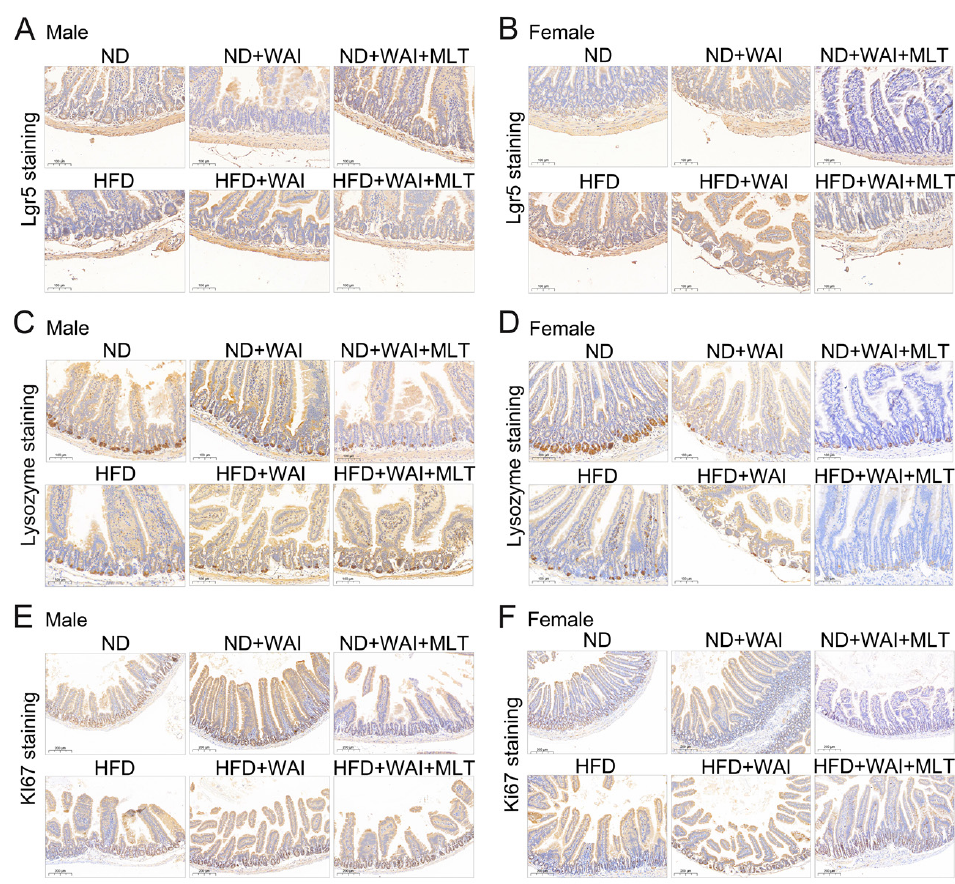
Figure 3. MLT enhances the regenerative ability of Lgr5 + ISCs after WAI. Representative immuno- histochemistry images showing the expression of Lgr5 + ( A ), lysozyme + ( C ), and Ki67 + ( E ) in small intestinal sections from male mice. Representative immunohistochemistry images showing the expression of Lgr5 + ( B ), lysozyme + ( D ), and Ki67 + ( F ) in small intestinal sections from female mice. (10 × magnification). (MLT, melatonin; WAI, whole abdominal irradiation). Muc2 is a mucoprotein secreted by IECs. It can infiltrate and protect the intestinal ep- ithelium [26]. Muc2 expression was detected using IHC staining. MLT treatment inhibited a reduction in Muc2 protein levels (Figure 4C,G). Nevertheless, the expression of Muc2 protein in HFD-fed male mice was significantly reduced compared with that in the ND group (Figure 4D,H). The above results suggest that an HFD induces sexual dimorphism in colon injury in male and female